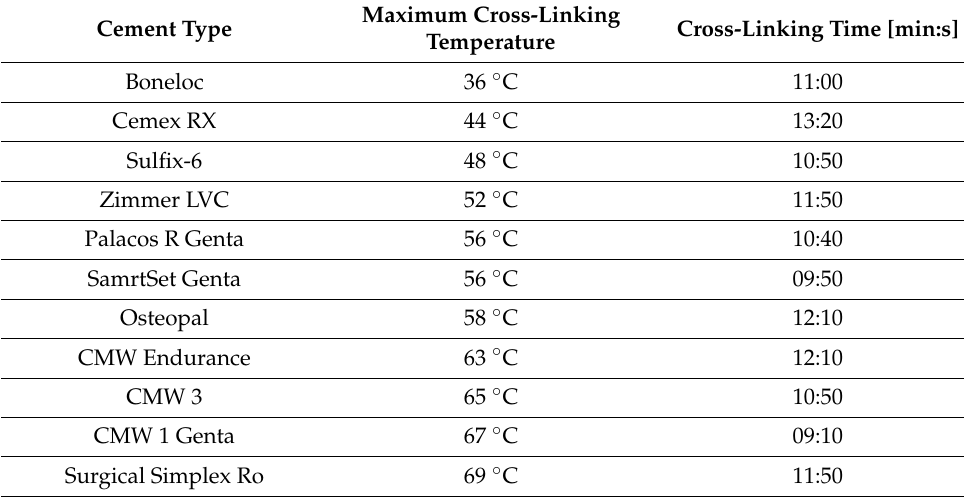
Table 1. The maximum temperature rise during cross-linking and cross-linking times of selected cements per ISO